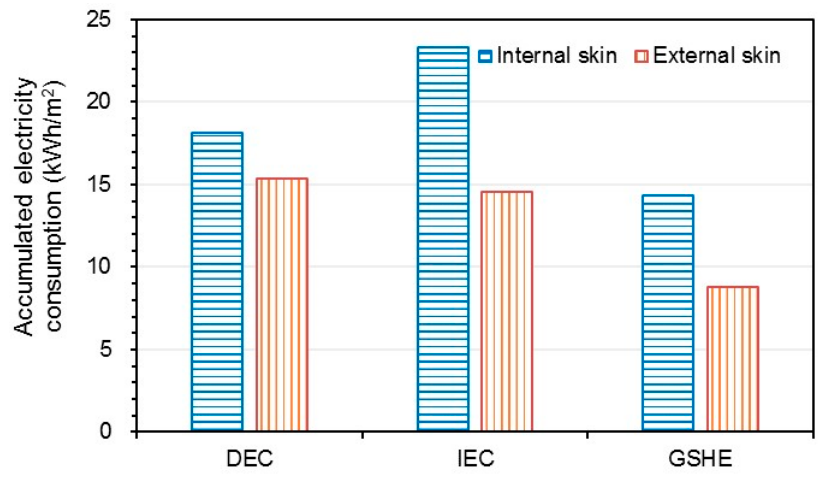
Figure 11. Accumulated electricity consumption for window with different insulation layouts.